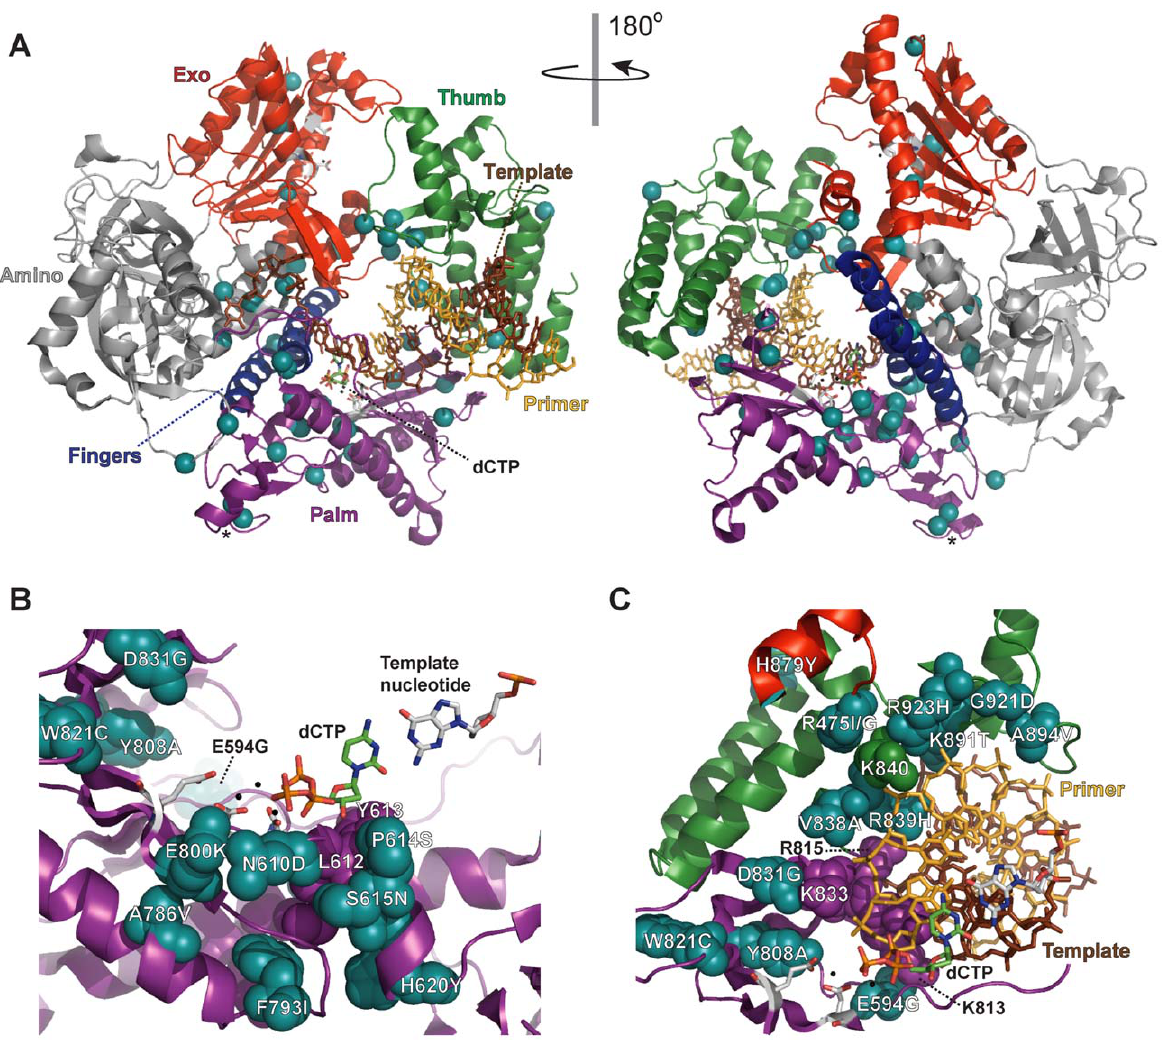
Figure 4. Locations of eex amino-acid substitutions in the S. cerevisiae Pol d structure. A) Overall distribution of eex amino-acid substitutions. The catalytic subunit of yeast Pol d is shown as a ribbon diagram with color-coded structural domains: amino, gray; exonuclease (Exo), red; palm, purple; fingers, blue; thumb, green. Other important elements are indicated as follows: DNA template strand, brown sticks; DNA primer strand, yellow sticks; incoming dCTP, green CPK sticks; metal ions, small black spheres; active-site residues, gray CPK sticks extending out from the a - carbon backbone in the palm and exonuclease domains. Residues changed by eex mutations are shown as light blue spheres. The asterisks mark adjacent E642K and D643N eex substitutions located on the solvent-exposed surface of Pol d . Structure from [74] (Protein Data Bank accession code 3IAY). B) Amino-acid substitutions near the polymerase active site. Palm domain eex residues are shown as space-filling spheres (light blue) and labeled to indicate the amino-acid substitutions. Important non-mutated residues proximal to the eex substitutions are also shown as space-filling spheres (purple). The fingers and thumb domains have been removed for clarity. C) Amino-acid substitutions in the DNA binding track. View looking down the DNA helical axis. The primer (yellow) and template (brown) are held by a series of interactions along the DNA minor groove. eex residues are light blue. Amino acids positioned by eex residues and minor-groove ‘sensing’ residues in the palm domain (K813, K814 and R815; [74]) are shown as space-filling spheres colored according to domain as in panel (A). The three unpaired 5 9 nucleotides of the template have been removed for